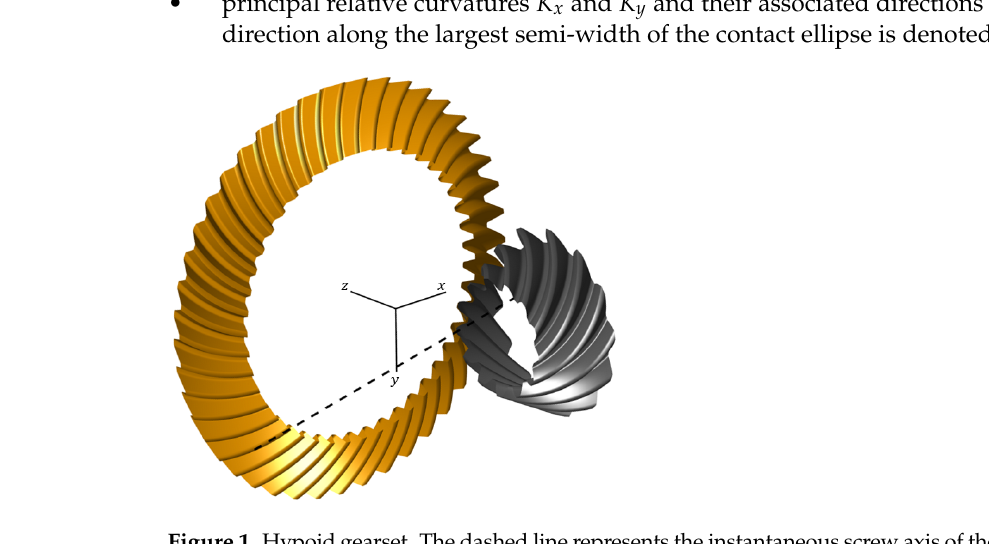
Figure 1. Hypoid gearset. The dashed line represents the instantaneous screw axis of the relative motion. ( i ) The principal normal curvature K of body j along direction τττ i is considered pos- j itive/negative if the normal plane through τττ i cuts body j producing a section with a convex/concave boundary